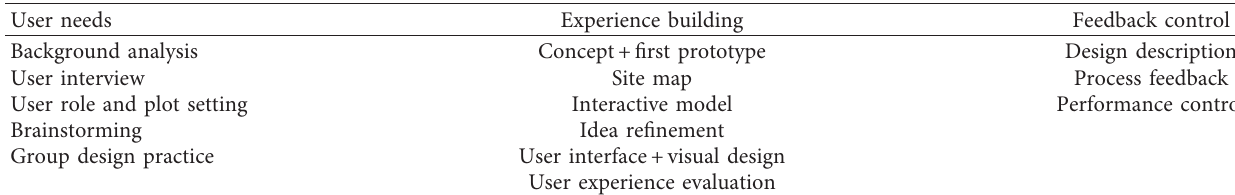
Figure 3: Display mode based on optical Table 1: User experience design process.